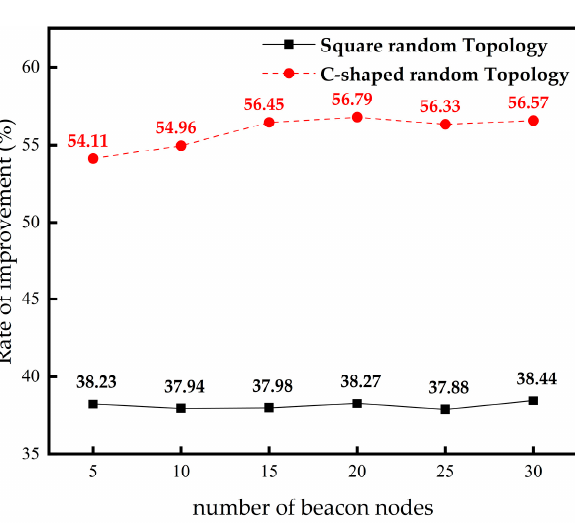
Figure 9. Comparison of localization error improvement in di ff erent number of anchor nodes.